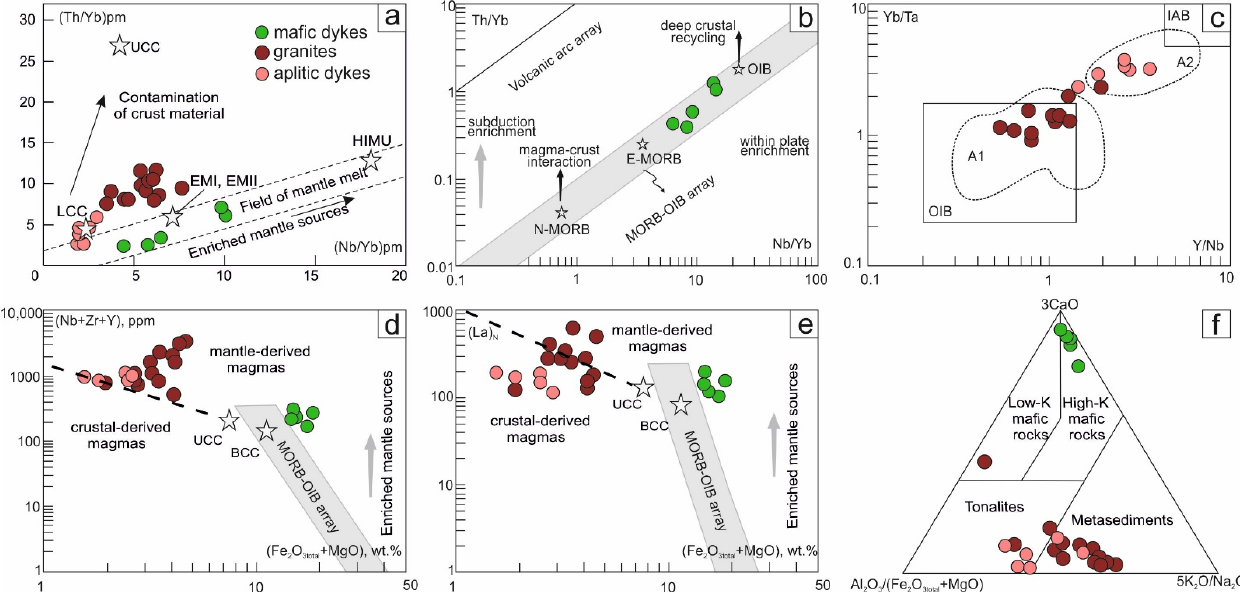
Figure 10. ( a ) (Th/Yb)pm–(Nb/Yb)pm diagram; UCC—upper continental crust; LCC—lower continental crust [63]; EMI, EMII, and HIMU (high μ = 238 U/ 204 U)—enriched mantle [64]; ( b ) Th/Yb–Nb/Yb diagram [65]; ( c ) Yb/Ta ‐ Y/Nb diagram [5]; ( d ) Nb + Zr + Y (ppm) Fe 2 O 3 t + MgO (wt %) diagram; ( e ) (La) N Fe 2 O 3 t + MgO (wt %) diagram [58]; UCC—upper continental crust; BCC—bulk continental crust [60]; MORB—mid ‐ ocean ridge basalts; OIB—ocean island basalts; ( f ) ternary diagram